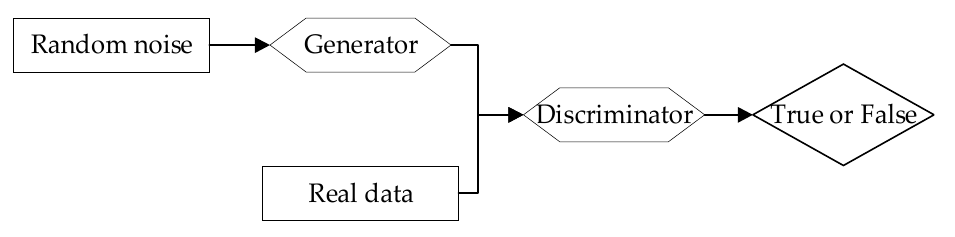
Figure 7. Structural diagram of GAN.